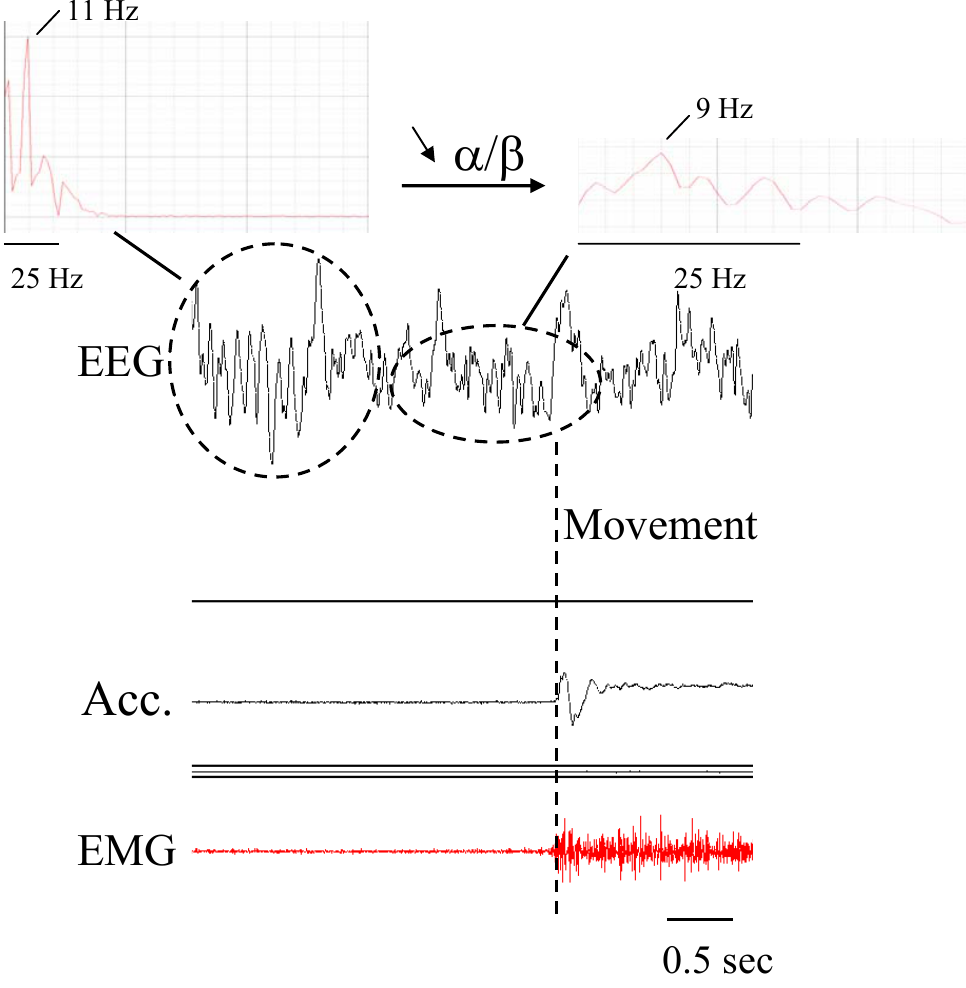
Figure 7. Example of change in alpha rhythm recorded with needle EEG on the scalp before a distal movement in contralateral upper limb. Preparation of movement is associated with a desynchronization of the EEG rhythm, with a decrease in the alpha/beta ratio. Upper panels correspond to power spectrum of EEG segments. Acc: accelerometer fixed on the hand; EMG: surface EMG in forearm muscle. Dotted vertical line: movement